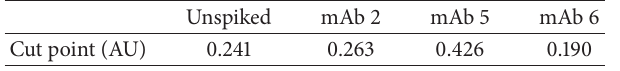
Table 1: Difference in background responses across three bio- therapeutics resulted in molecule specific screening cut points following a floating population data approach. Serum samples from 30 cynomolgus monkeys were spiked with 3 mAbs in early assay development experiments. The unspiked and mAb-spiked samples were analyzed in the generic assay format and a floating population screening cut point was evaluated. Different backgrounds were observed in the samples spiked with three mAbs compared to the unspiked corresponding samples. Therefore, molecule specific screening cut points were obtained for each mAb.